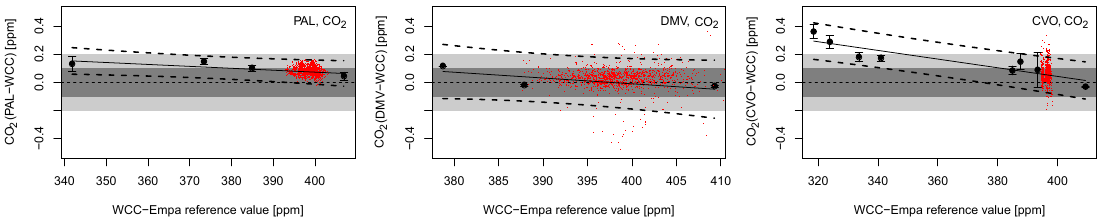
Figure 9. Results of the CO 2 travelling standard comparisons (performance audits) at PAL (left), DMV (middle) and CVO (right). The grey areas correspond to the WMO/GAW compatibility (dark grey) and extended compatibility (light grey) goals. The red points correspond to the observed differences based on hourly data during the ambient air comparison. Solid and dashed lines represent the fit and the 95% confidence intervals for the linear regression through the travelling standard comparison.